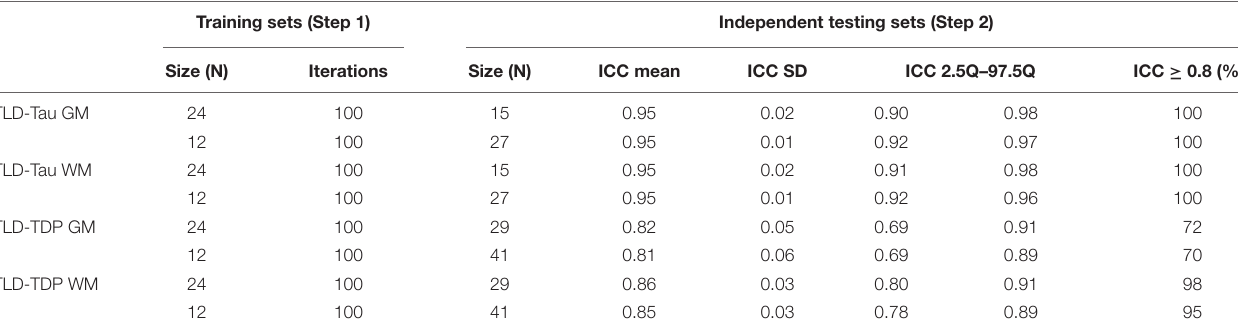
TABLE 3 | Transformation outcomes in independent complementary testing sets (Step